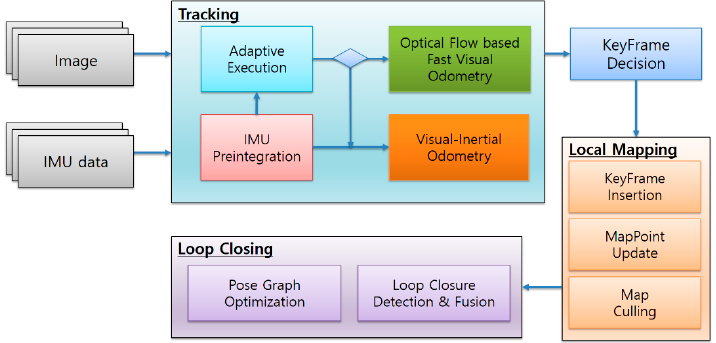
Figure 1. Structural architecture of adaptive visual–inertial simultaneous localization and mapping (SLAM).